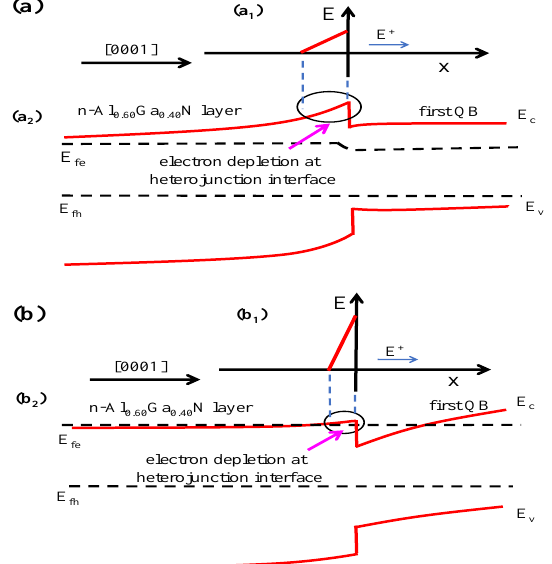
Figure 2. Schematic energy diagrams and electric field profiles within the heterojunction interface for the structures ( a ) with a low Si doping concentration in the X region and ( b ) with a high Si doping concentration in the X region. E c , E v , E fe , and E fh represent the conduction band, the valence band, the quasi-Fermi levels for electrons, and holes, respectively.